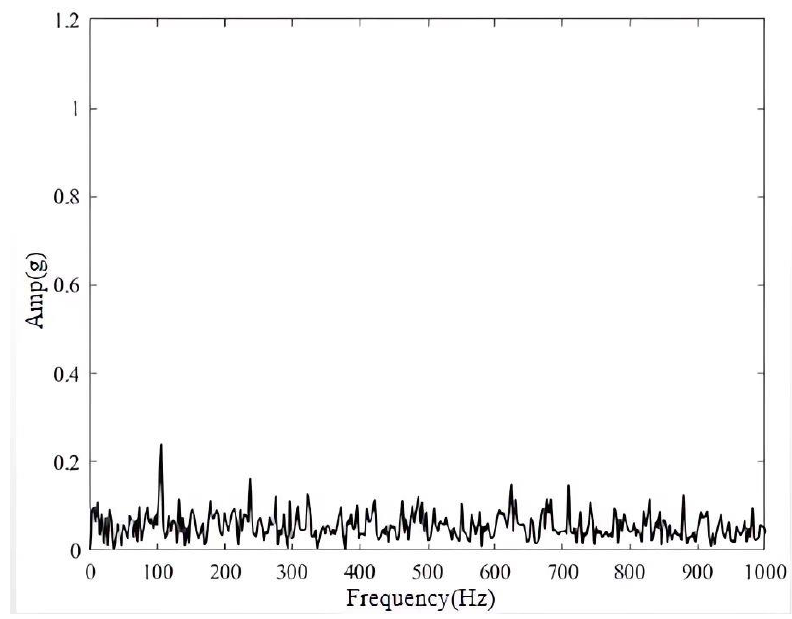
Figure 8. Optimal component envelope diagram of EMD.